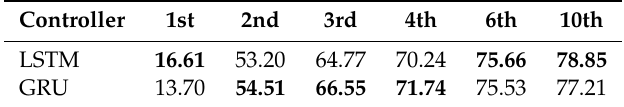
Table 9. A comparison of the model using 2 types of controller: LSTM and